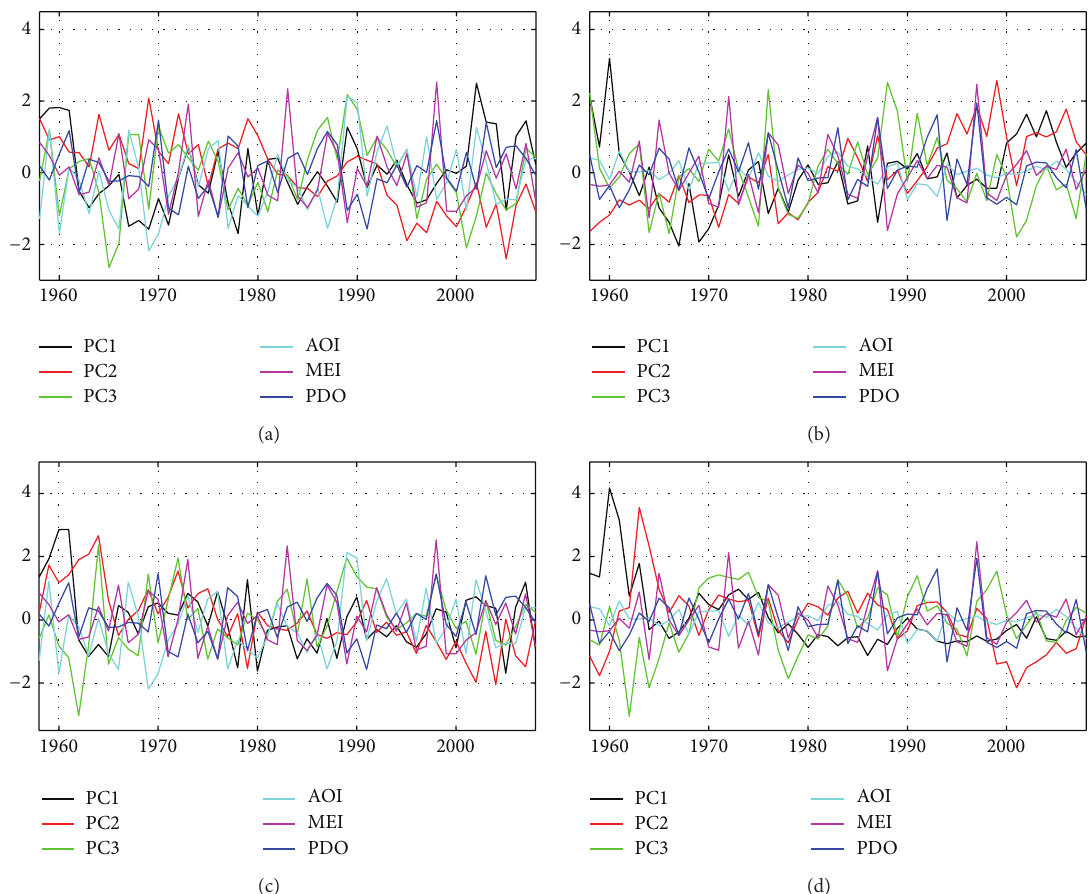
Figure 7: Interannual time series of (a) winter AO, MEI, PDO, EOF1, EOF2, and EOF3 of winter heat flux; (b) summer AO, MEI, PDO, EOF1, EOF2, and EOF3 of summer heat flux; (c) winter AO, ENSO, PDO, EOF1, EOF2, and EOF3 of winter wind stress; (d) summer AO, MEI, and PDO, and EOF1, EOF2, and EOF3 of summer wind stress. EOF1, EOF2, and EOF3 of heat flux and wind stress are standardized.